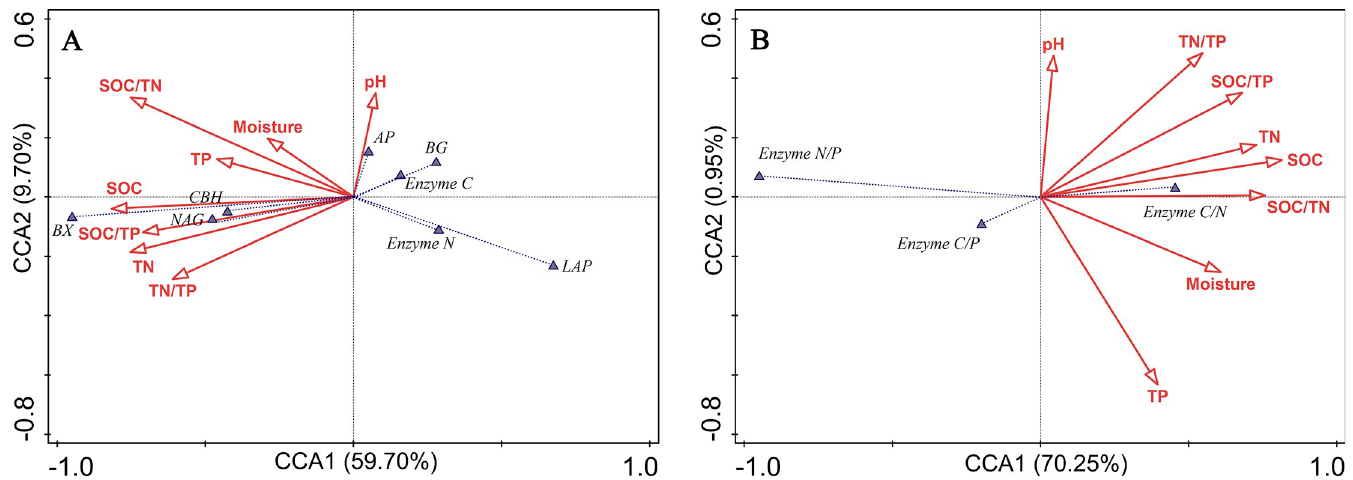
Fig 5. Canonical correspondence analysis (CCA) between environmental variables and (A) soil enzyme activities, and (B) soil enzyme stoichiometry . Moisture: soil moisture, SOC: soil organic carbon, TN: total nitrogen, TP: total phosphorus, BG: β -1,4-glucosidase, BX: β -xylosidase, CBH: β -D-cellobiosidase, NAG: β - 1,4-Nacetylglucosaminidase, LAP: L-leucine aminopeptidase, AP: acid phosphatase. Enzyme C, Enzyme N and Enzyme P represent (BG + BX + CBH), (NAG + LAP) and AP, respectively. Enzyme C/N, C/P and N/P represent (BG + BX + CBH)/(NAG + LAP), (BG + CBH)/AP and (NAG + LAP)/AP, respectively.